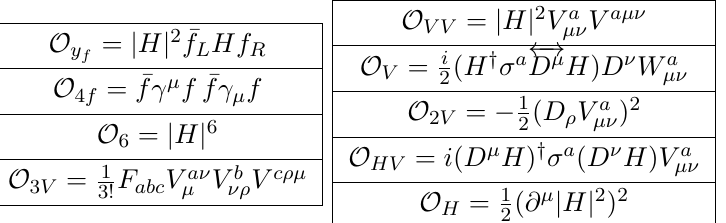
((cid:12)fth line). (cid:21) 4 f denotes the (cid:13)avor 1 = 2